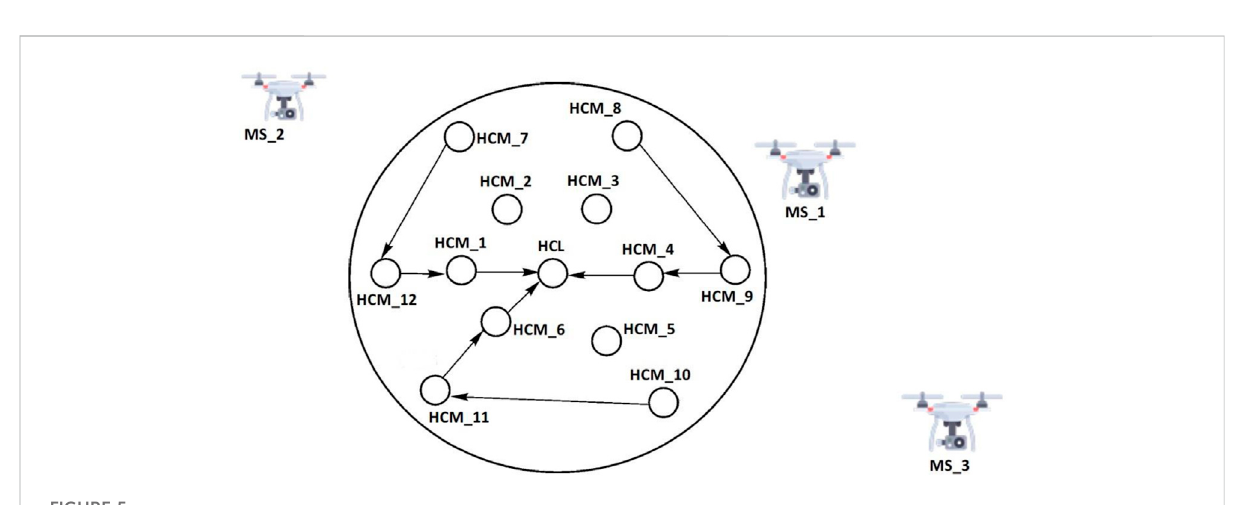
FIGURE 5 Recovery